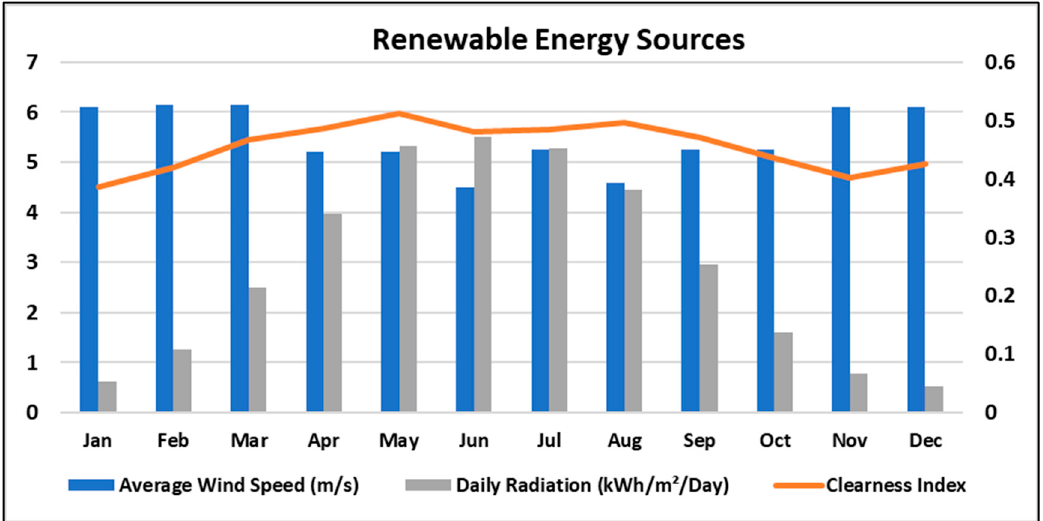
Figure 4. The average monthly renewable energy source (RES) generation data at DTU-Risø .